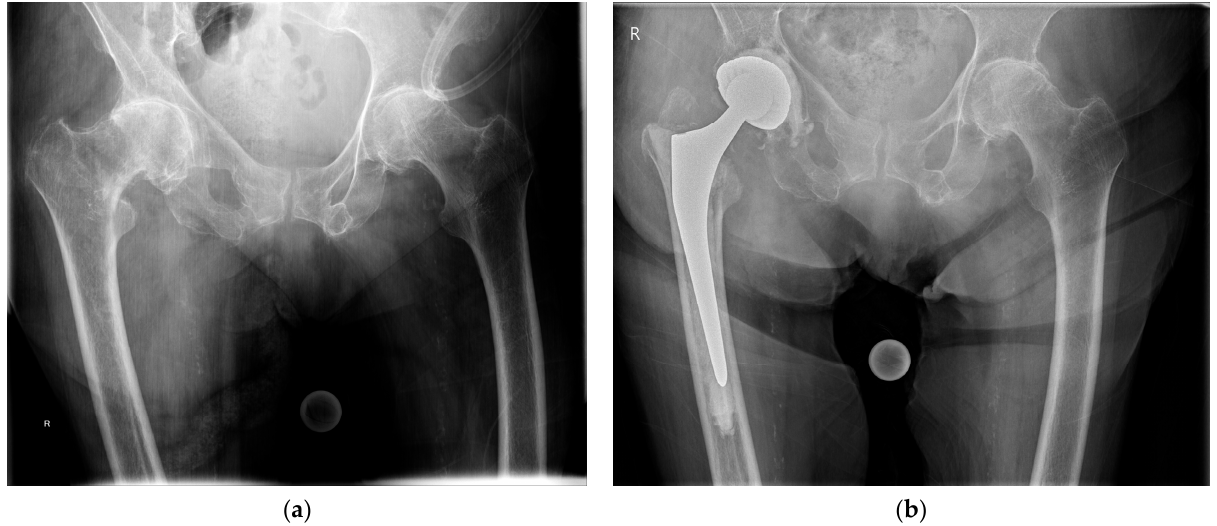
Figure 1. ( a ) Preoperative anteroposterior pelvic radiograph of an intertrochanteric femur fracture with concomitant advanced osteoarthritis of the right hip; ( b ) anteroposterior pelvic radiograph at 1 year after total hip arthroplasty with a cemented femoral stem and a cemented double-mobility acetabular cup.